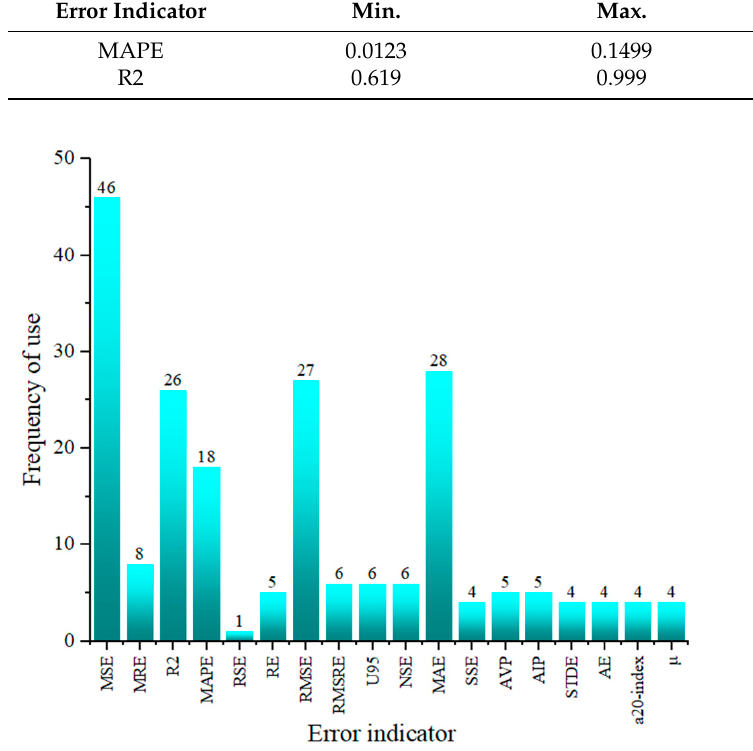
Figure 11. The frequency of using various error indicators in 71 models.